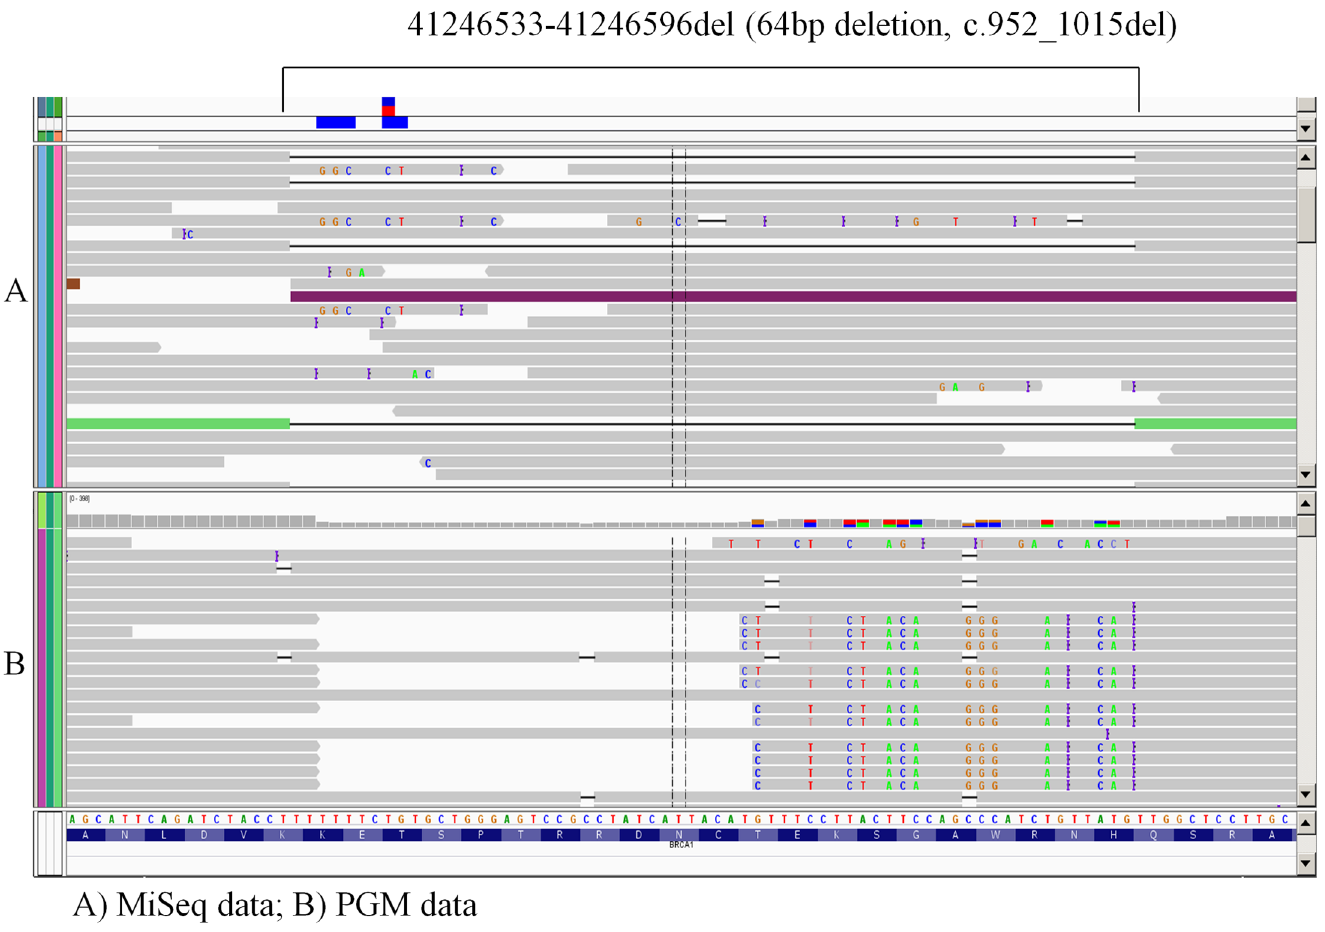
Fig 3. Alignment of a 64 bp-deletion (41246533-41246596del; c.952_1015del) in a validation sample. The Integrative Genomics Viewer (IGV) graphic reports show detection of the deletion using MiSeq platform with QSAP (panel A) but not the PGM platform with Torrent Suite variant calling software (panel